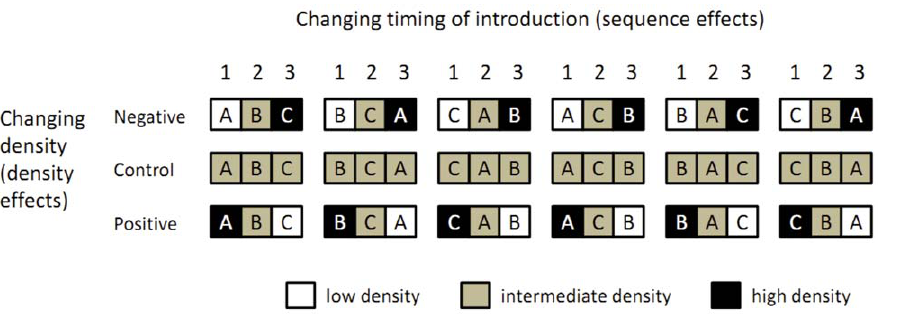
Figure 1. Experimental design for microcosms of the three protozoan species. Cells represent first, second, and third introductions (from left to right) of species into microcosms at 12-hour intervals; shading indicates low, intermediate, and high densities of protozoa in the aliquots introduced. Species A, Poterioochromonas malhamensis ; species B, Colpoda steinii; species C, Eimeriidae gen. sp.